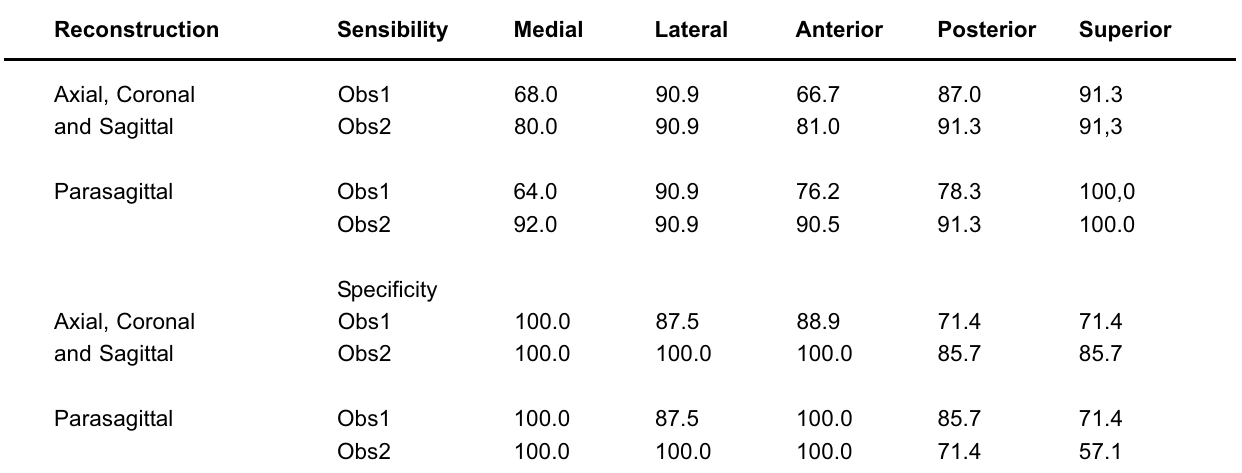
TABLE 3- Table of the values of sensibility and